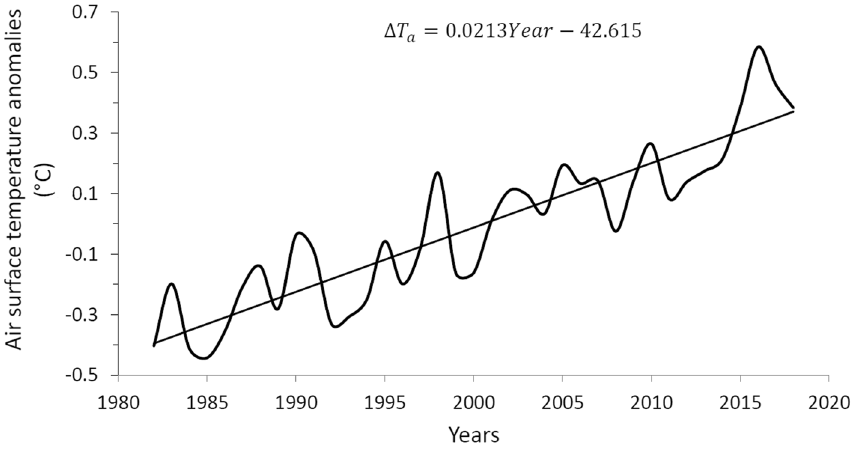
Figure 4. Global and annual anomaly (which is equivalent to what in this work we have called increase (cid:31) ) of the air temperature at 2 m above the surface, obtained from the ERA5 Reanalysis for the period of 37 years from 1982 to